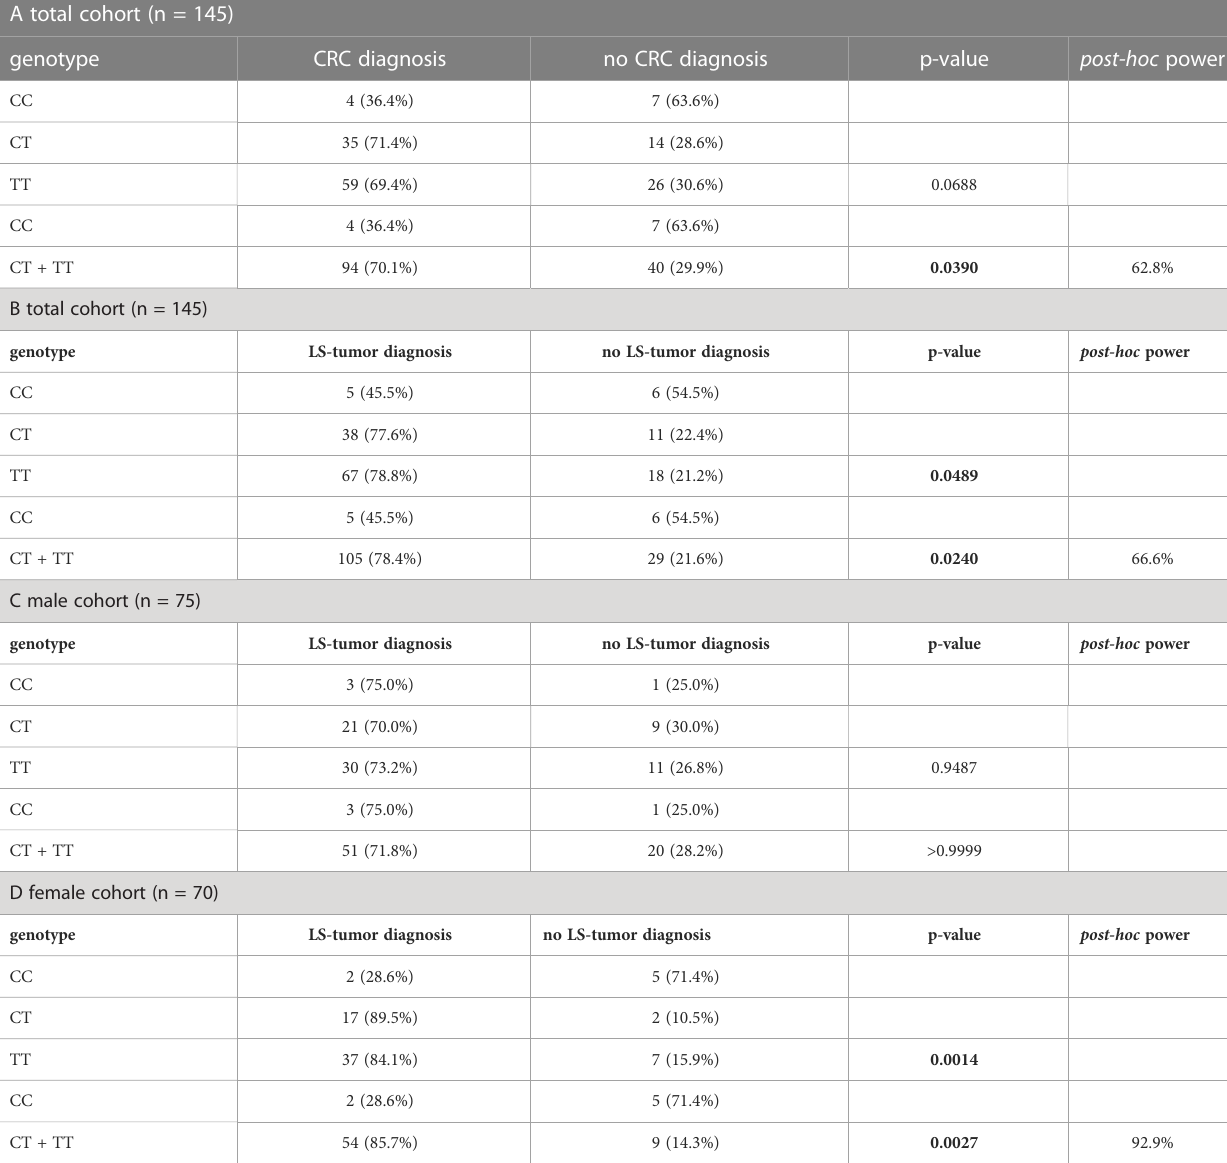
TABLE 2 Analysis of frequencies of CRC and LS-associated tumors in LS individuals based on their rs8192917